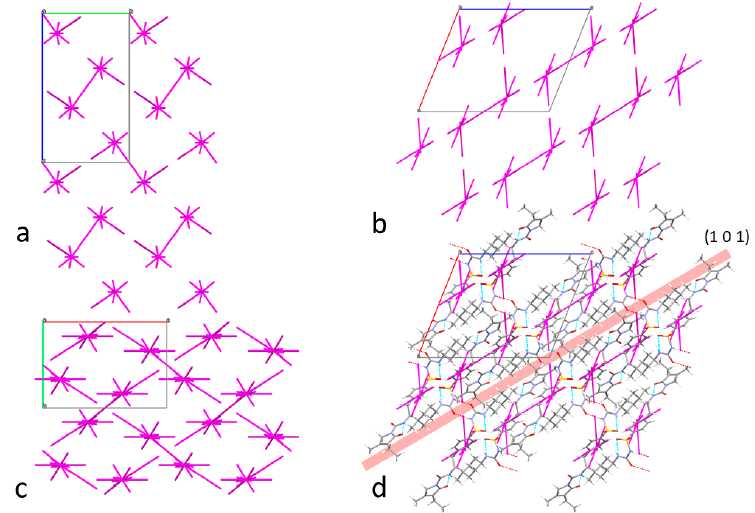
Figure 7. Energy vector diagrams (EVDs) plots viewed along the a—( a ), b—( b ), and c—( c ) crystallographic axis together with an illustration of the (101) slip plane ( d ). Table 2. Numbering of dimers, symmetry operation of second molecule of dimer and corresponding intermolecular interaction energy of dimers formed by the basic molecule in the crystals (dimers showing the strongest interaction are highlighted in bold).